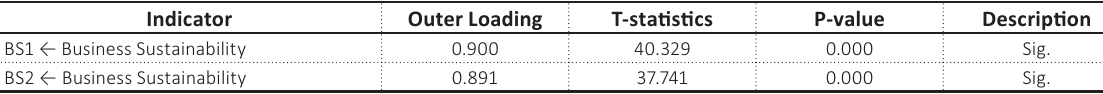
Source: Own elaboration using PLS.